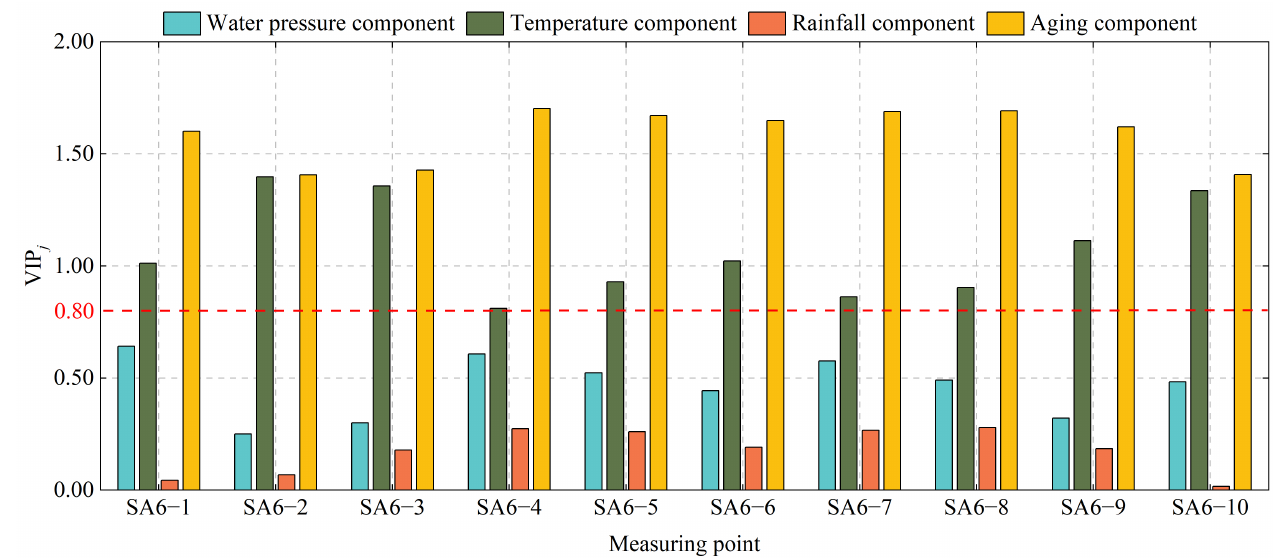
Figure 4. Comparison between measured value and repaired value of vertical deformation meas- uring points.